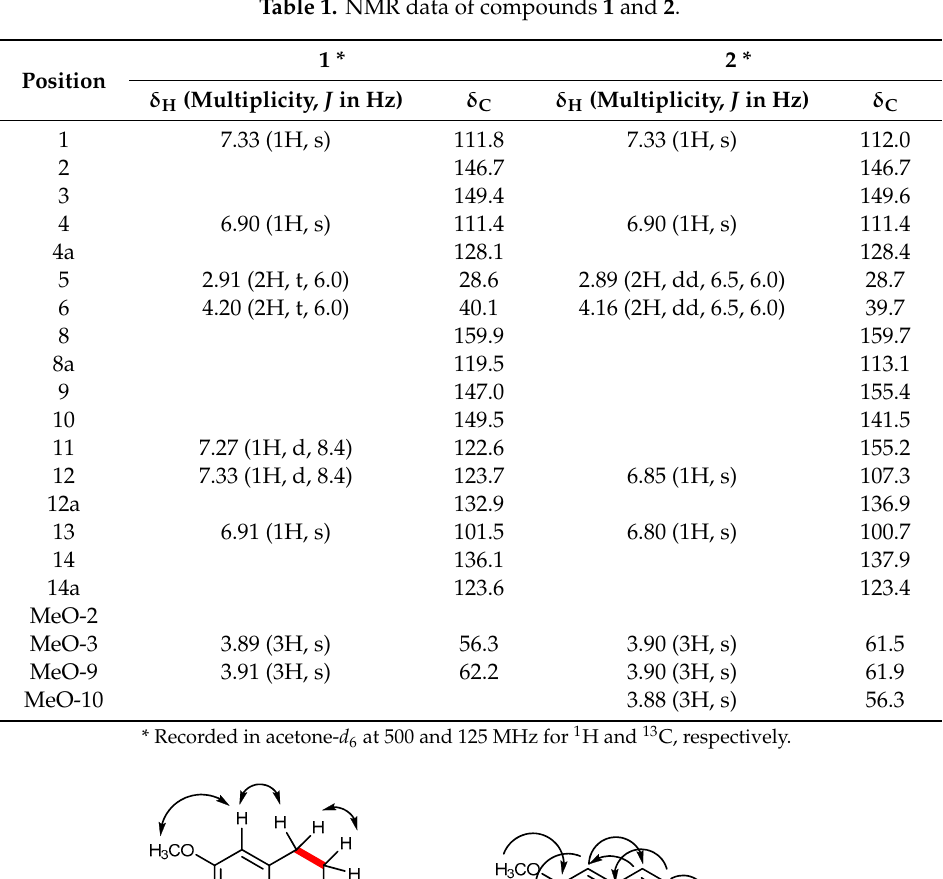
Table 1. NMR data of compounds 1 and 2 .